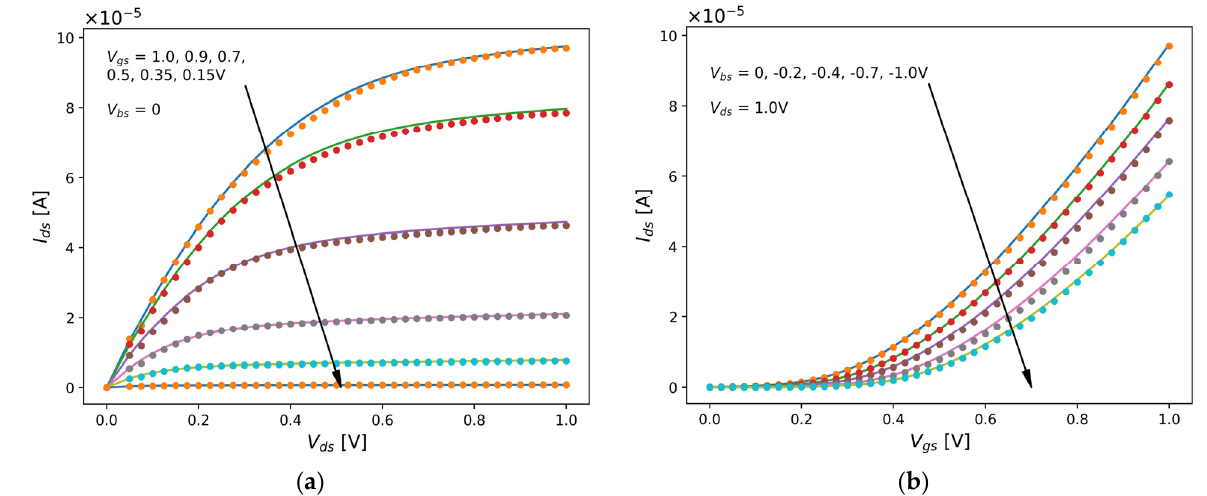
Figure 10. IV fitting curves for the first set of inputs: ( a ) I ds –V ds curves at different V gs when V bs = 0;